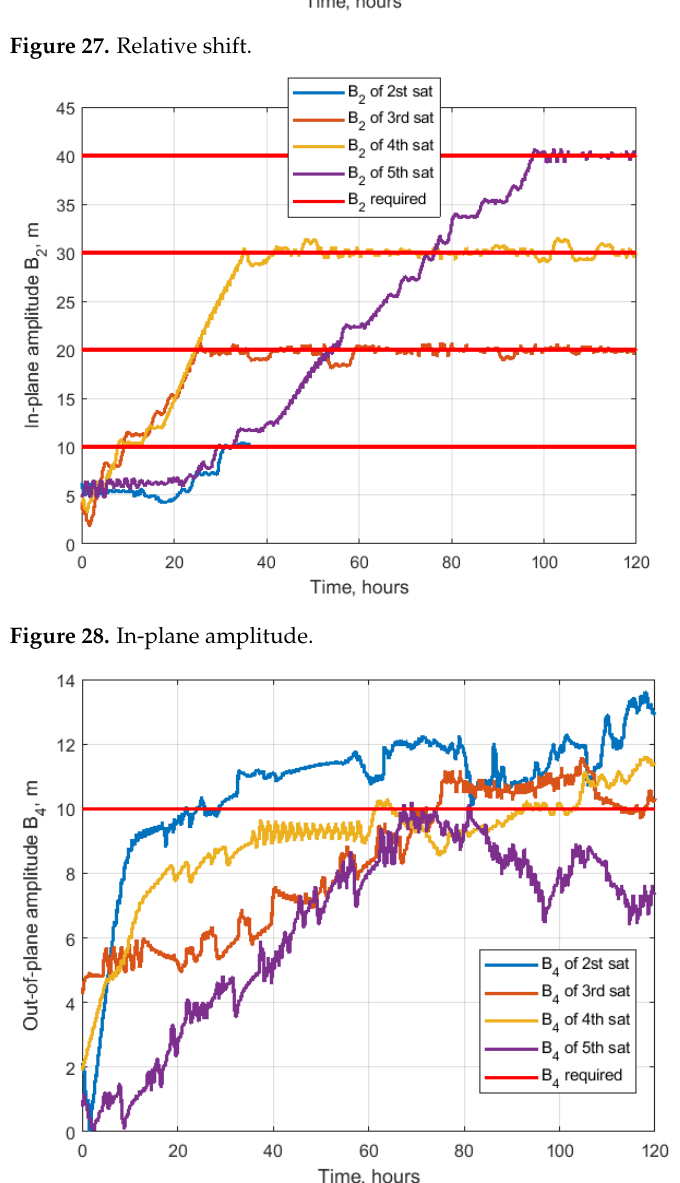
Figure 29. Out-of-plane amplitude.